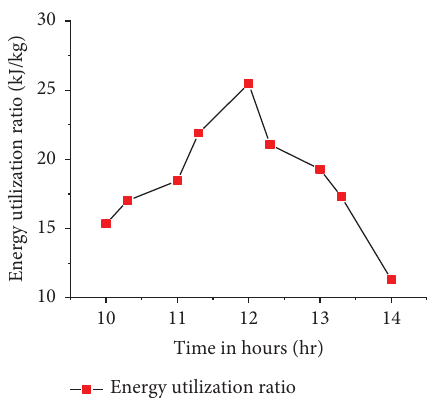
Figure 4: Variation of the energy utilization ratio with the dehydrating period.